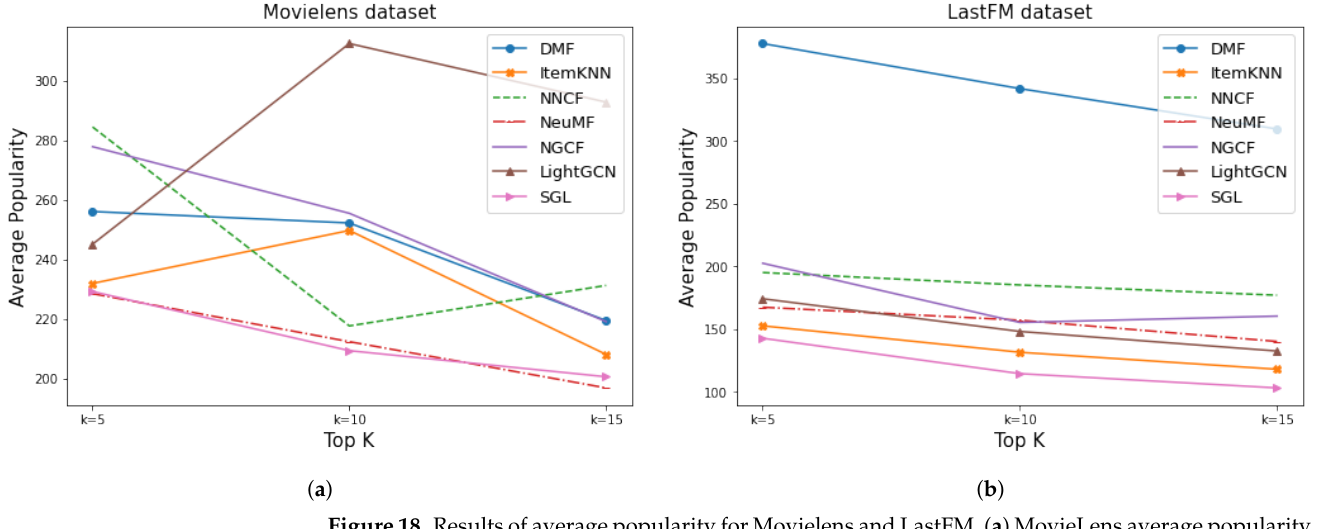
Figure 18. Results of average popularity for Movielens and LastFM. ( a ) MovieLens average popularity. ( b ) LastFM average